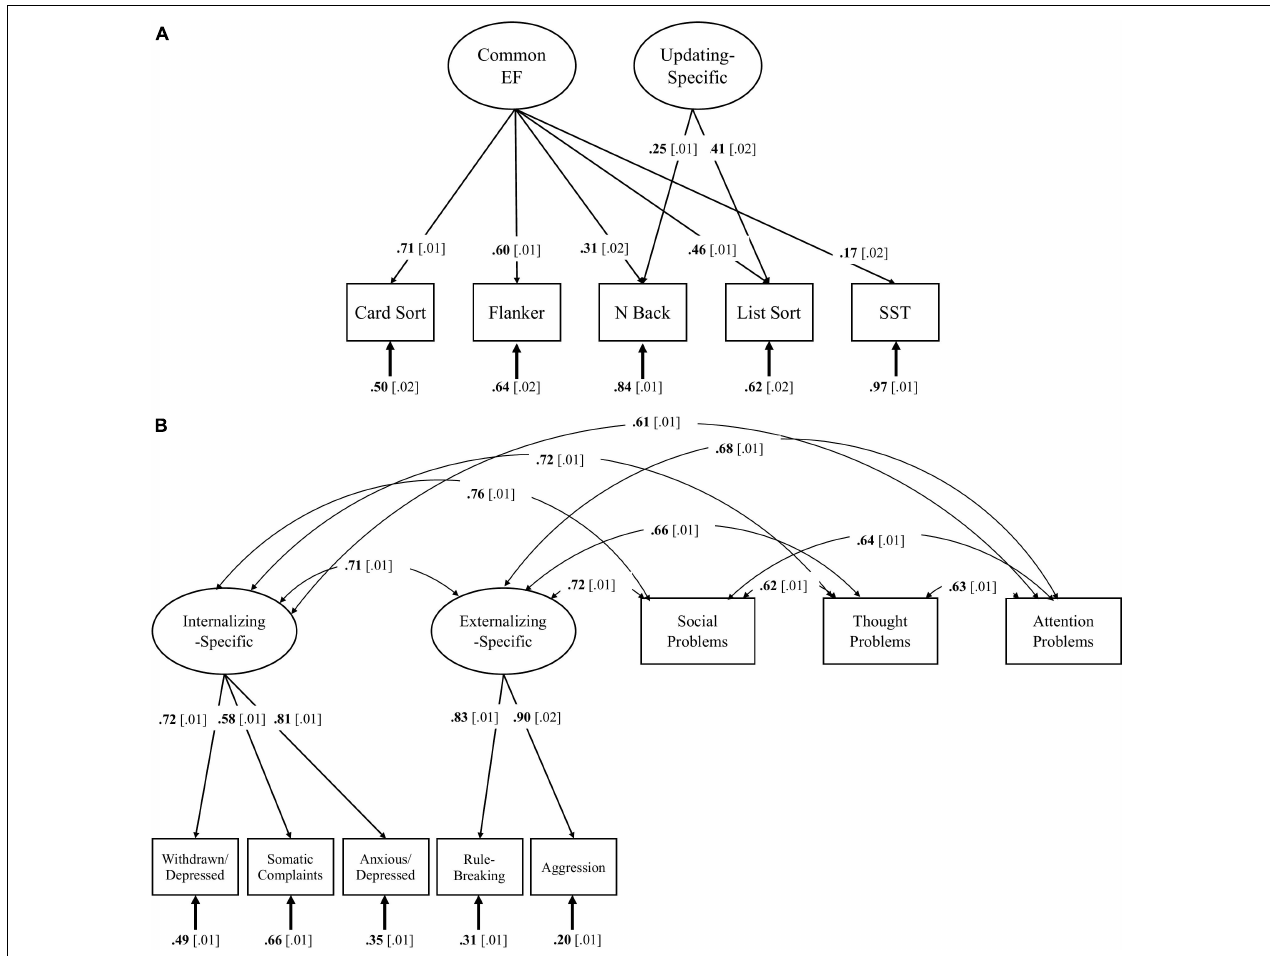
FIGURE 1 | Phenotypic factor model of the unity/diversity model executive function (EF) originally presented in Freis et al. (2022) (A) and the correlated factors model of psychopathology (B) . Ellipses signify latent variables; rectangles signify observed variables. Numbers on single-headed arrows signify standardized factor loadings. Numbers in brackets are standard errors. Numbers at the ends of arrows are residual variances. Double headed arrows signify correlations. Solid lines and boldface type signify p <